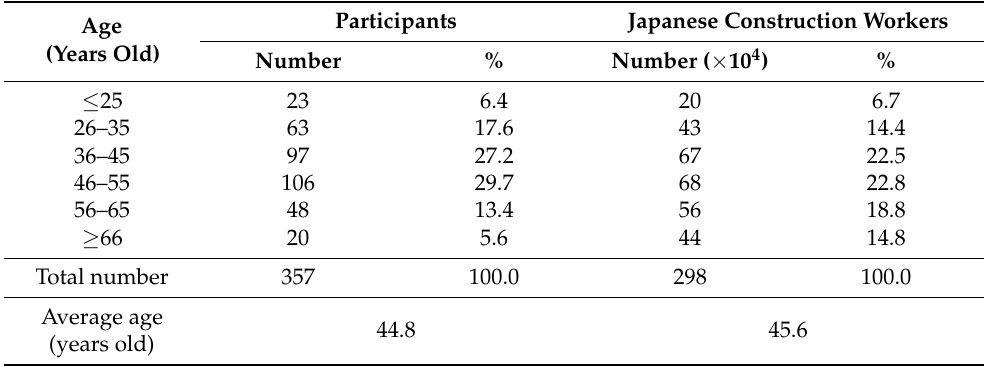
Table 7. The distribution of age groups among the participants and Japanese construction